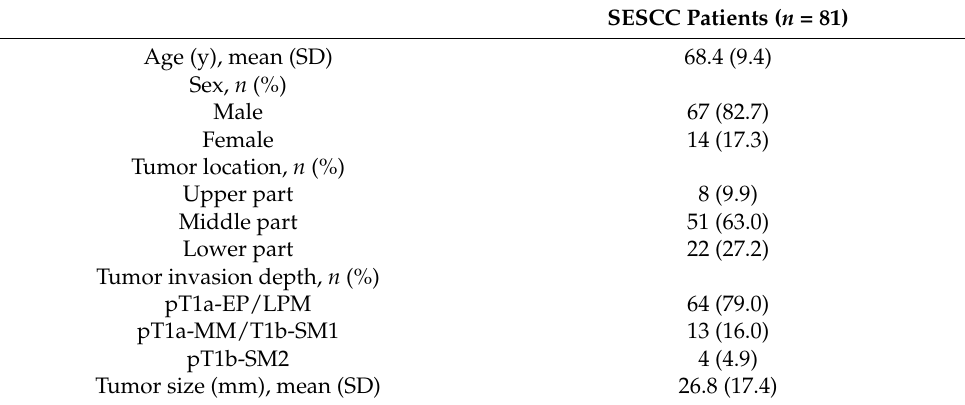
Table 1. The baseline characteristics of the enrolled patients.